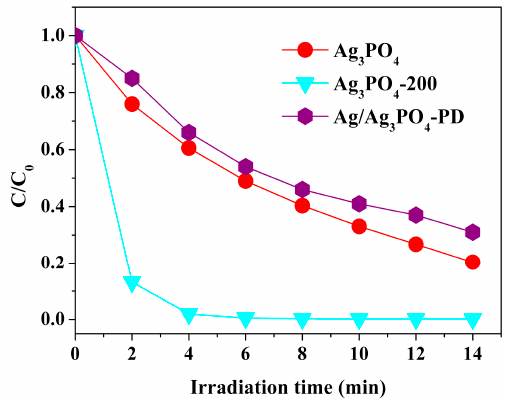
Figure 13. Photocatalytic degradation of MB over pristine Ag 3 PO 4 , Ag/Ag 3 PO 4 -PD, and Ag 3 PO 4 -200 under visible light